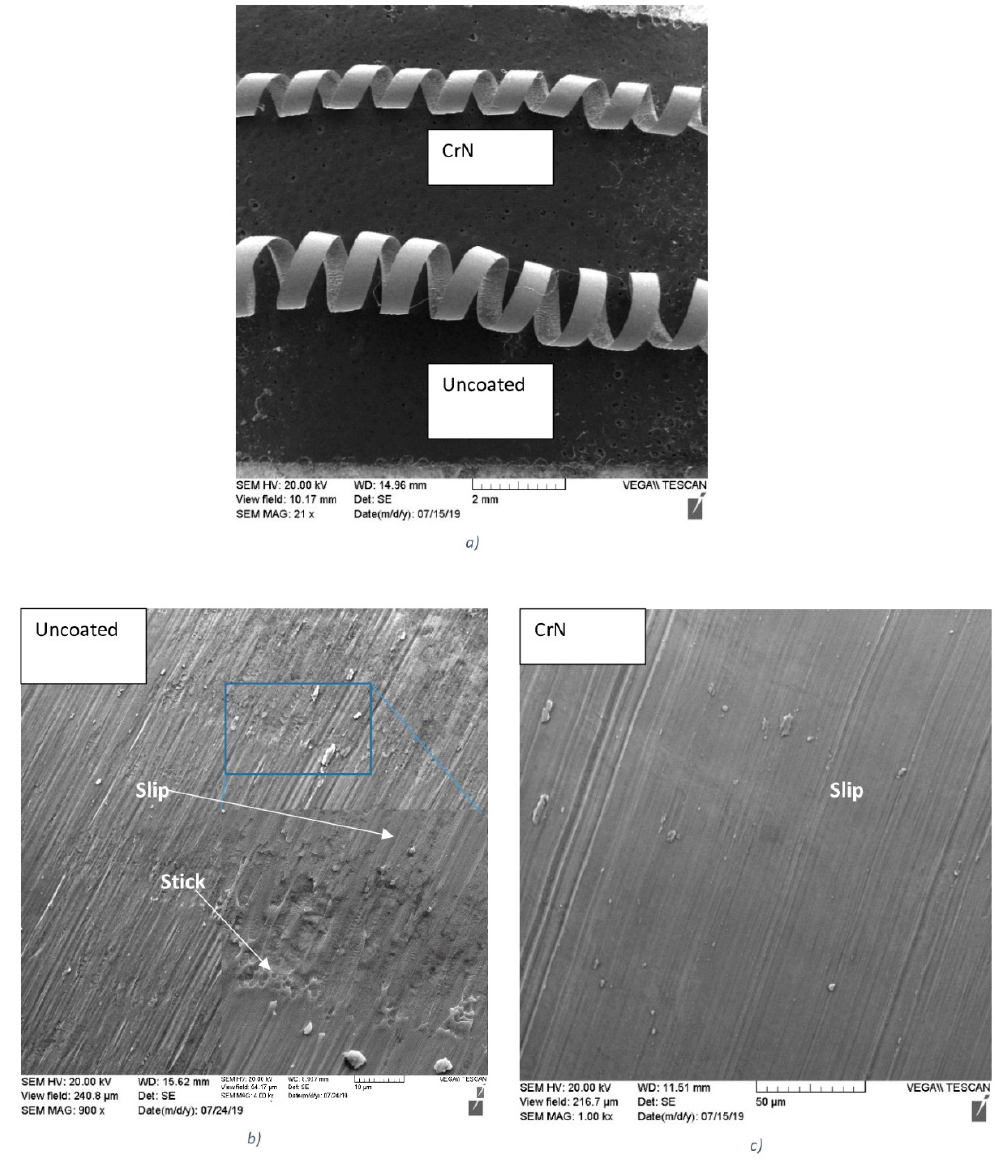
Figure 12. Type of chips ( a ) and morphology of the chip undersurface for the—( b ) uncoated and ( c ) CrN coated cutting tools during machining of Ti 6 Al 4 V alloy.